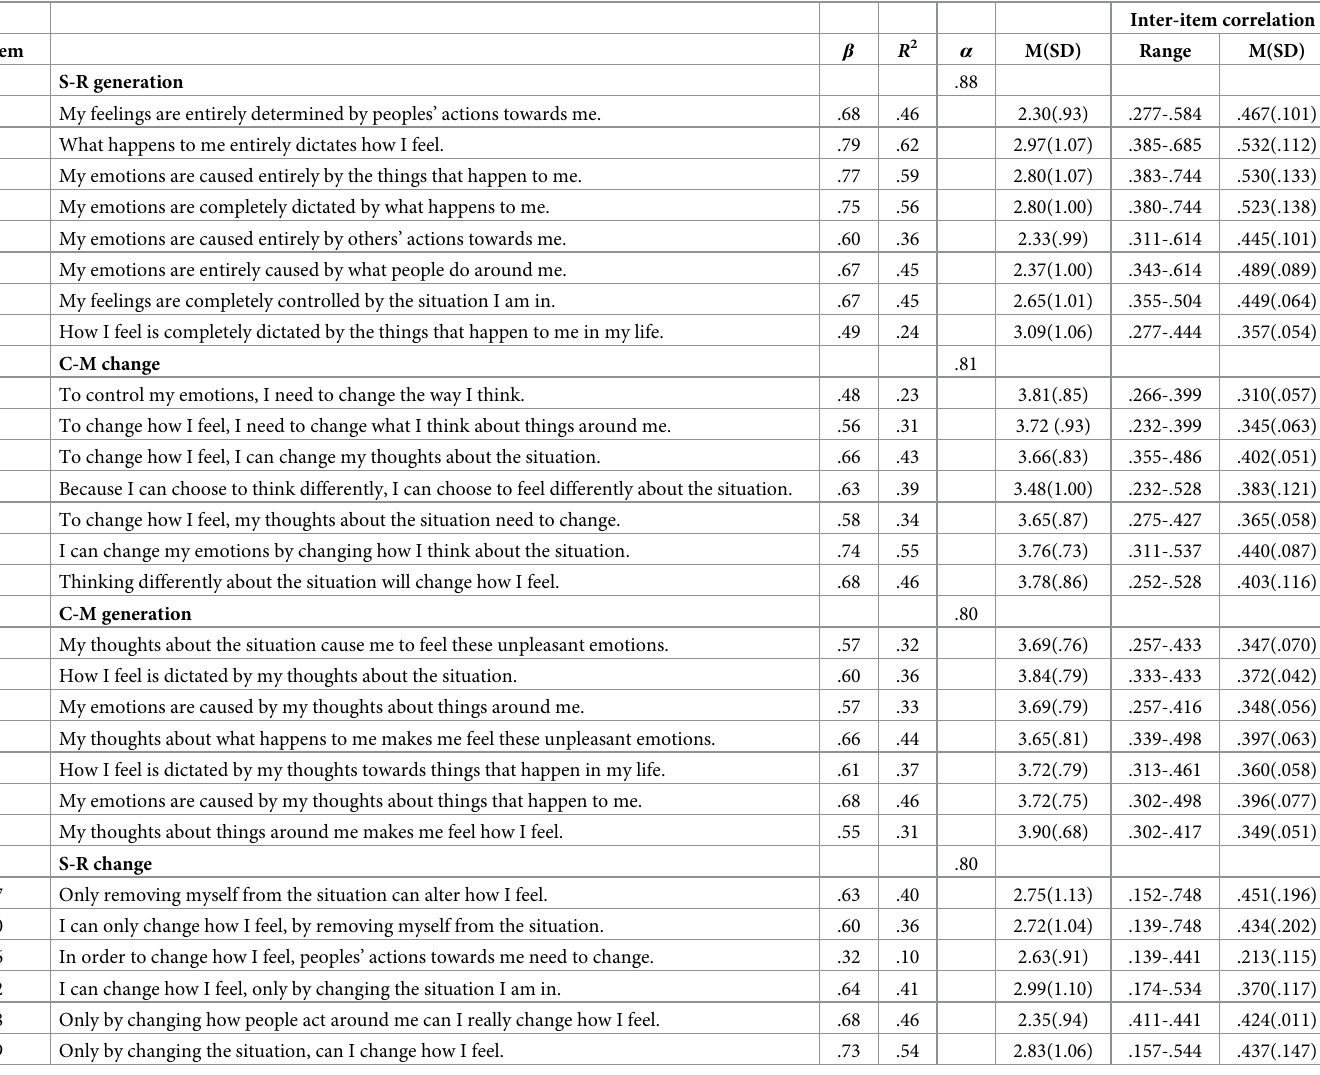
Table 4. Item properties, internal consistency, inter-item correlations, and descriptives, of the 28-item CMBQc (CMBQa and CMBQb combined) in study 4.